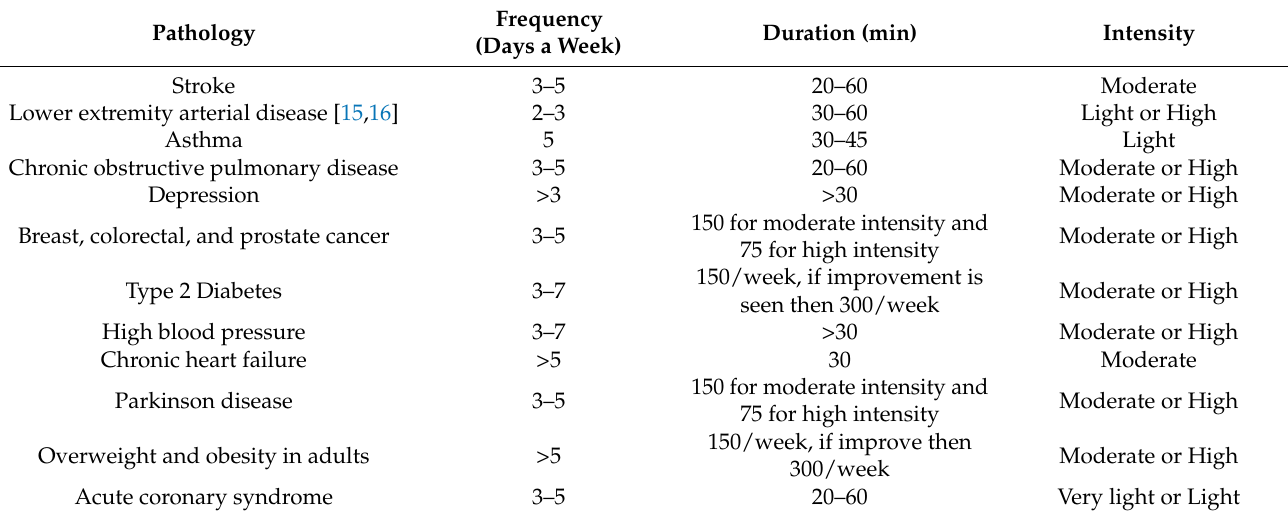
Table 1. HAS pathology list and their recommended physical activity.